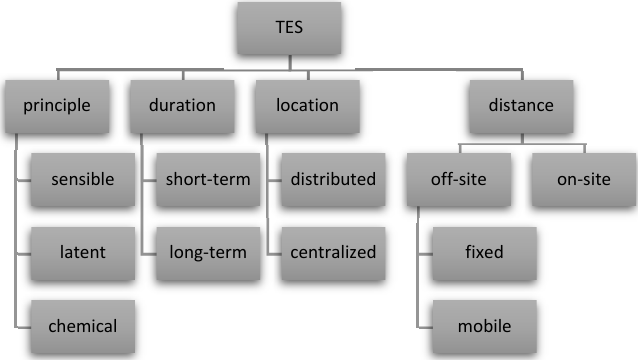
Figure 2. TES for low-temperature heat sources in DH and cooling [10].